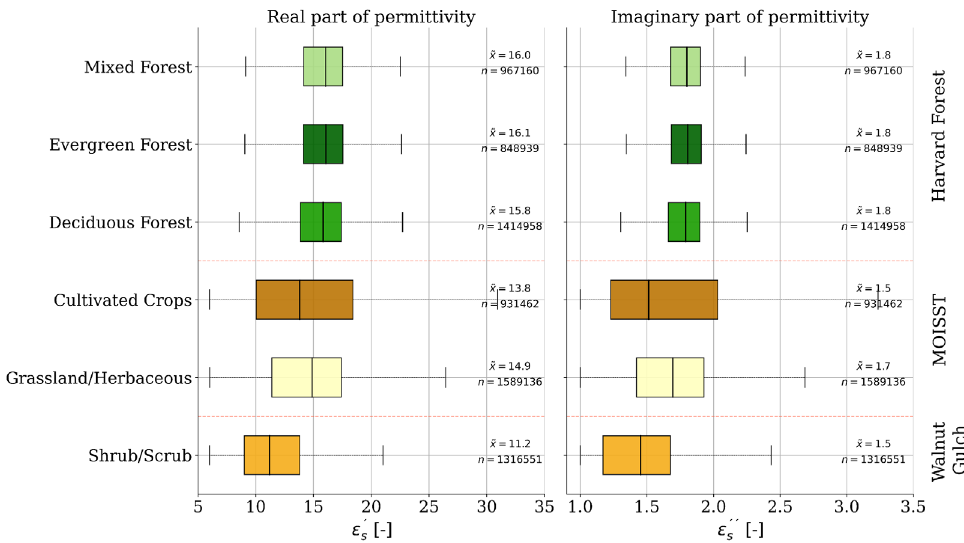
Figure 7. Estimated real ε (cid:48) s ( left ) and imaginary ε (cid:48)(cid:48) s ( right ) part of complex soil permittivity for main land cover classes of the AirMOSS monitoring sites Walnut Gulch, MOISST, and Harvard Forest. The results are displayed for all acquisition dates (Figure 1, Section 2). (cid:101) x represents the respective median value, n is the total amount of values per boxplot.